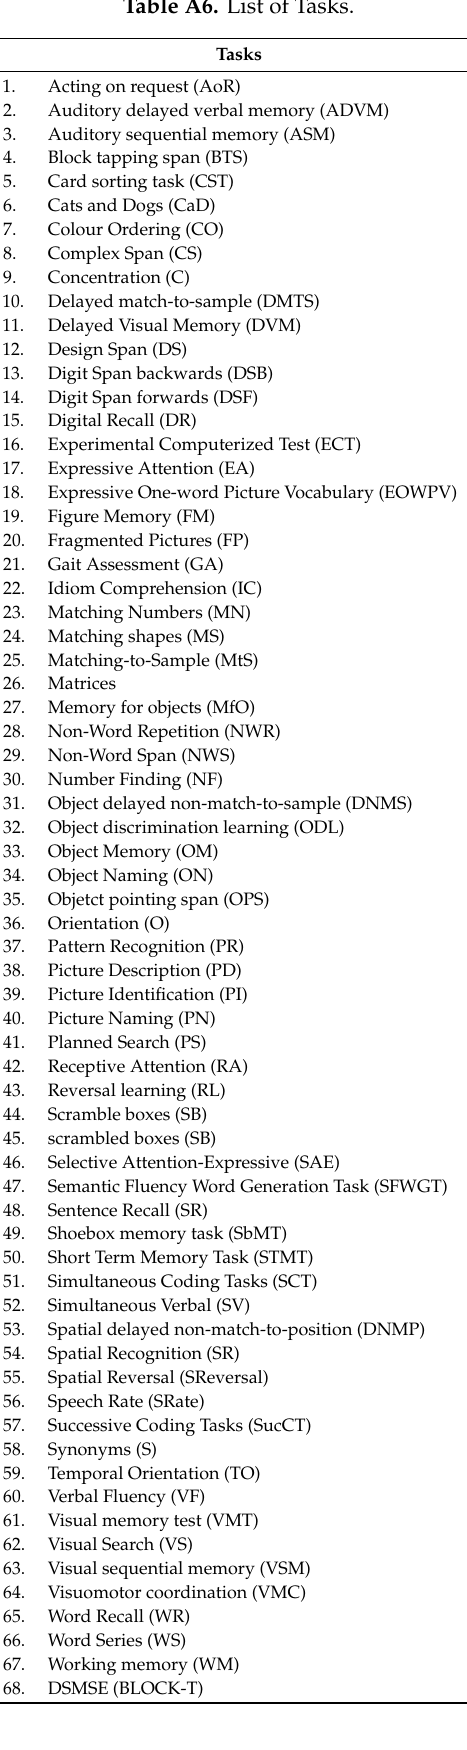
Table A6. List of